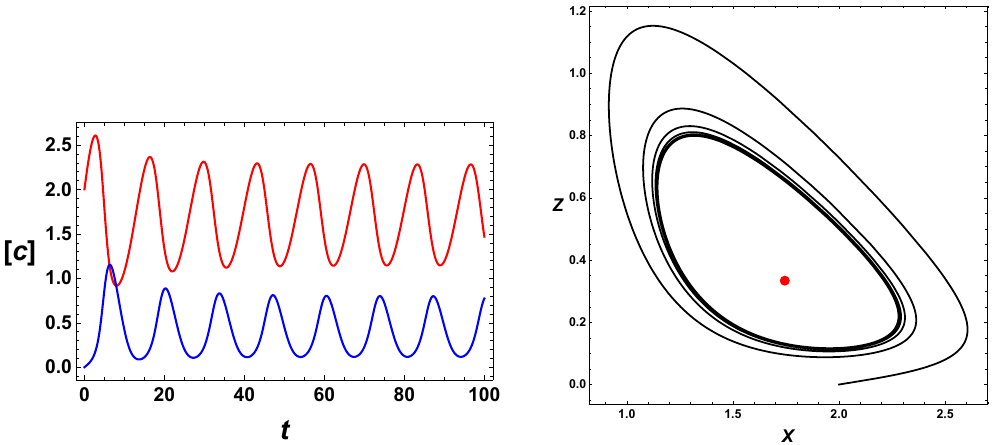
Figure 5. Left panel, time series for X and Z with k u = 0.01, r = 0.4, K = 0.50 and φ = 1. Right panel, phase plot X vs. Z, with the unstable steady solution depicted as a red